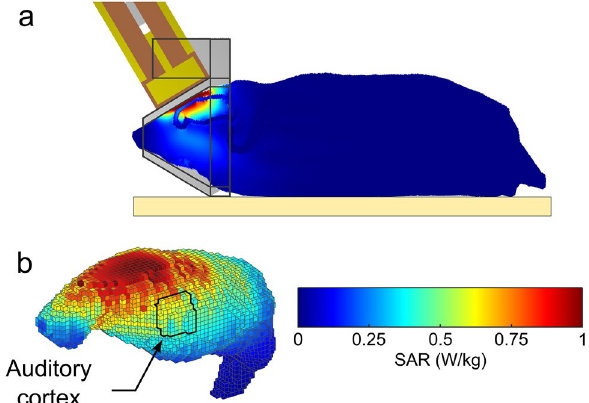
Figure 2. Dosimetric analysis of Specific Absorption Rates (SARs) in the rat brain during exposure to 1800 MHz LTE. The heterogeneous model of phantom rat and loop antenna previously described 62 was used to evaluate the local SAR in the brain with a 0.5 mm 3 cubic mesh. ( a ) Global view of the rat phantom in the exposure setup with the loop antenna above its head and the metal-free heat pad (yellow) under the body. ( b ) Distribution of SAR values in the adult brain at 0.5 mm 3 spatial resolution. The areas delimited by black contours in sagittal sections correspond to the primary auditory cortex in which microglia and neuronal activity were analyzed. The color-coded scale of SAR values applies to all numerical simulations shown in the